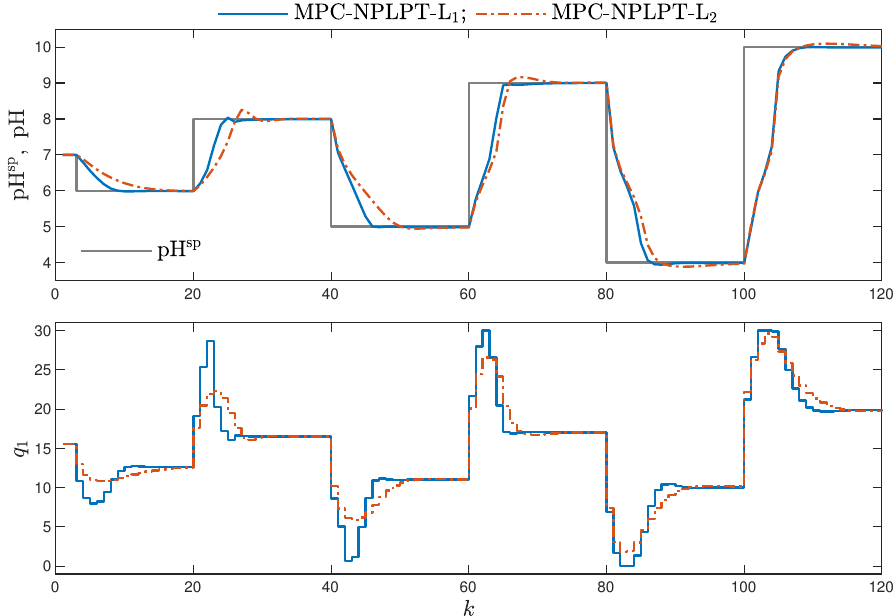
Figure 8. Simulation results: the MPC-NPLPT-L 1 algorithm vs. MPC-NPLPT-L 2